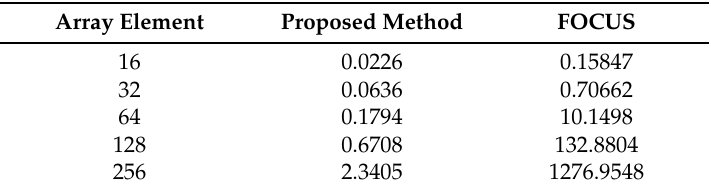
Table 5. Time cost by using the proposed method and FOCUS, respectively, for different array apertures (seconds).